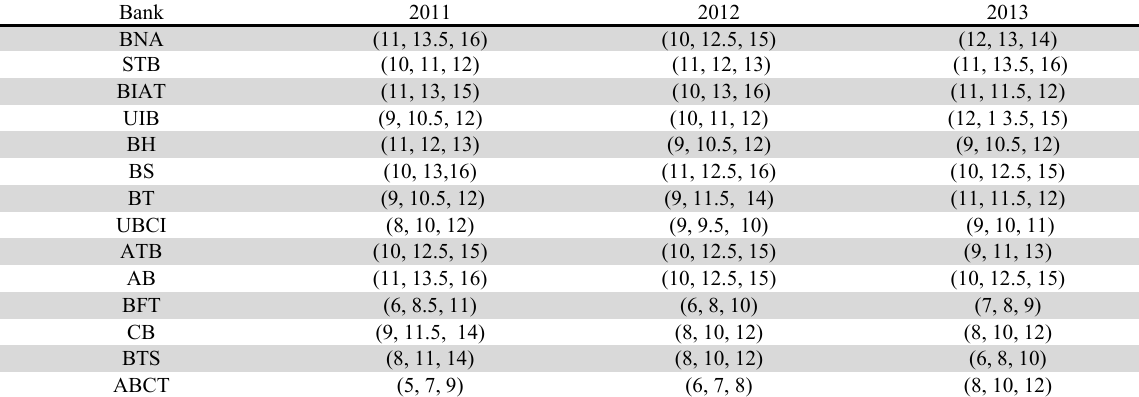
The customer’s satisfaction data